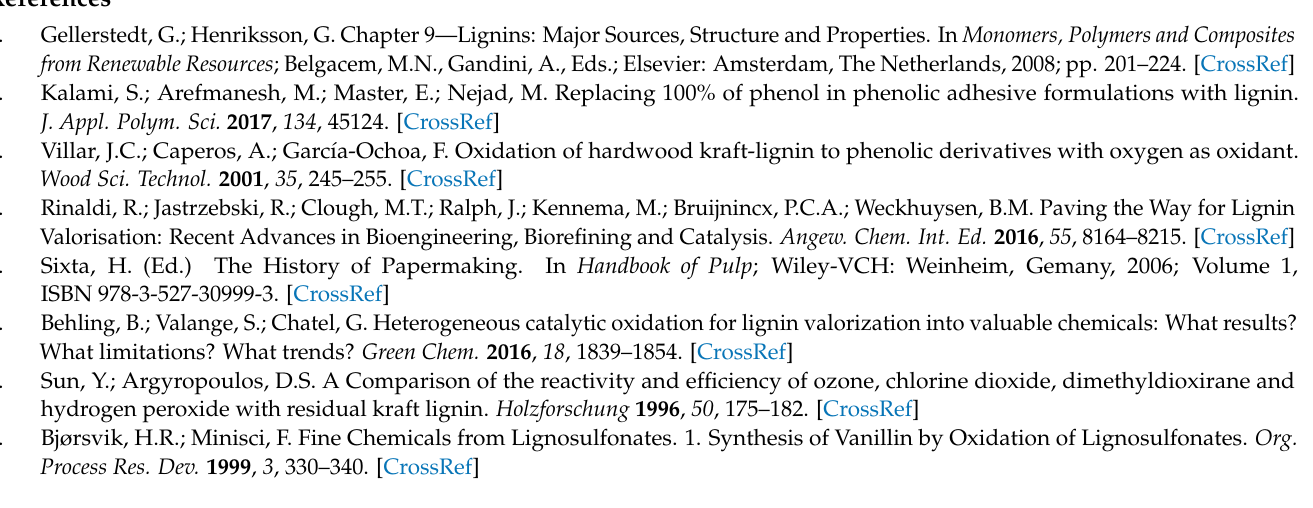
(orange); Figure S2: 31P NMR of LN1; Figure S3: 2D HSQC NMR of LN1 before and after oxidative depolymerization with a focus on aliphatic (on the right) and aromatic (on the left) areas; Figure S4: SEC chromatogram of LN1 lignin (blue curve) and the influence of the oxygen pressure at 180 ◦ C on LNP and LNW molar masses.; Figure S5: SEC chromatogram of LN1 (red curve) and LN2 (black curve) before oxidative depolymerization and the LNP and LNW fractions obtained from these both lignin respectively (all experiments was performed with 10 bar O 2 and 120 ◦